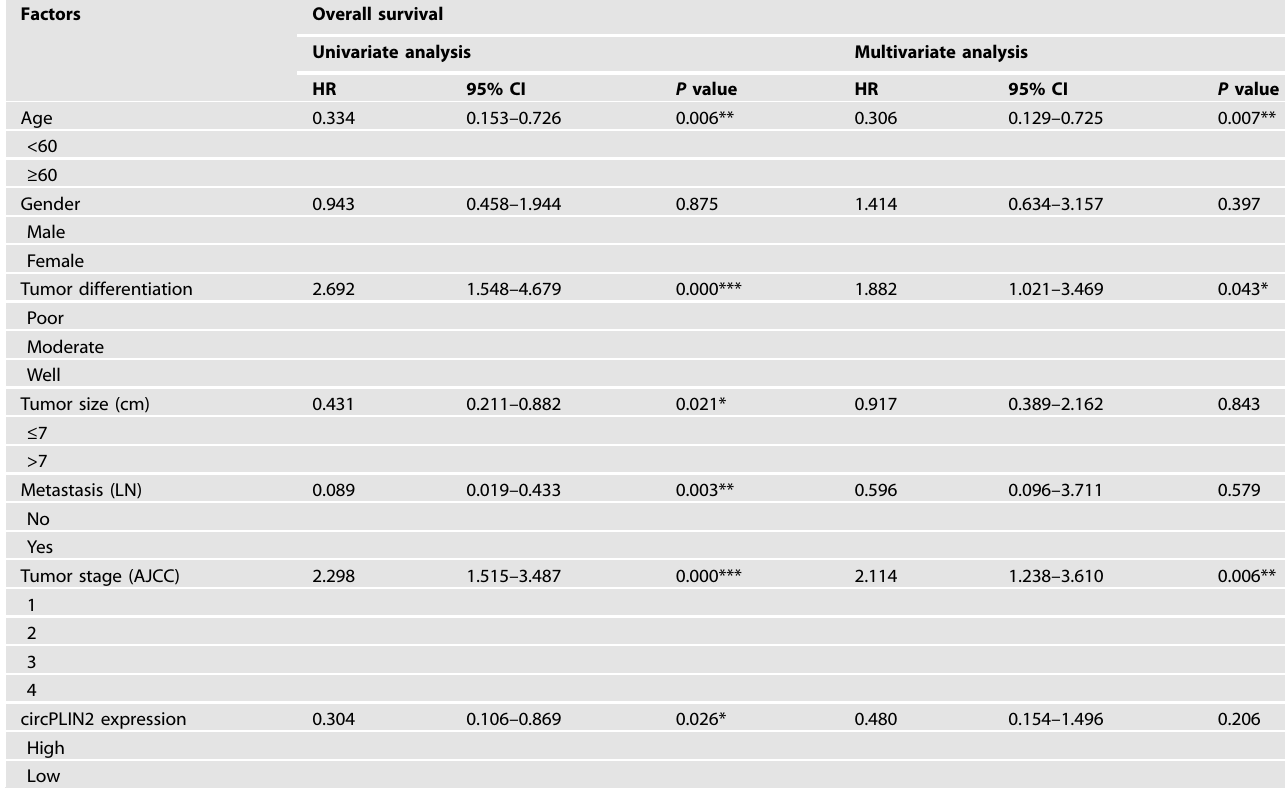
Table 2. Univariate and multivariate analyses of factors associated with the overall survival in 78 ccRCC patients with signi fi cantly higher or lower expression of